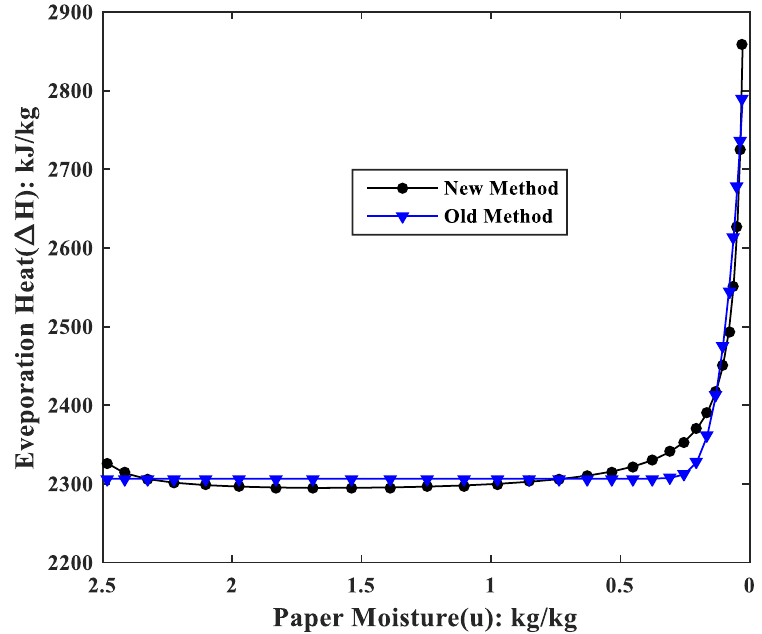
Figure 4. Comparison of results between the new and old methods in the laboratory.